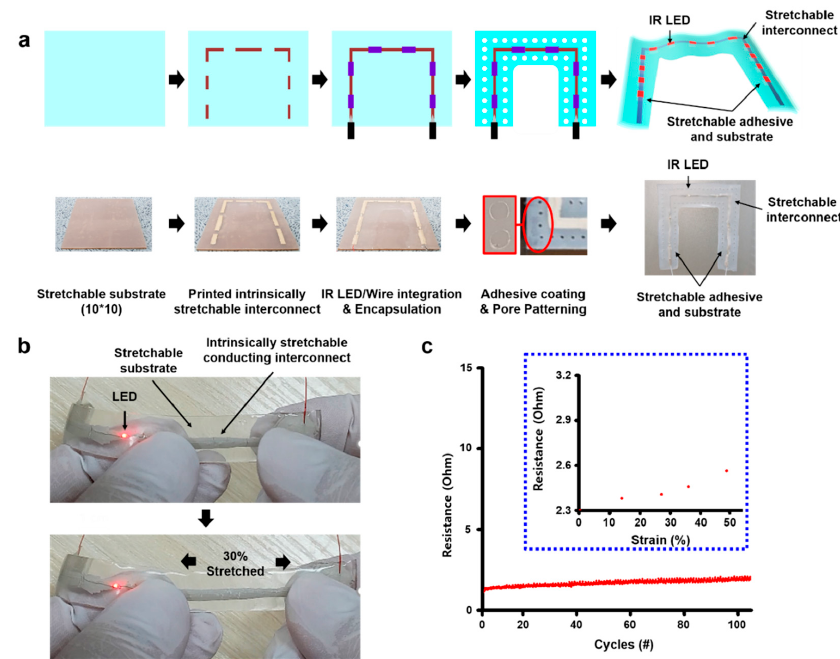
Figure 2. Marker patch fabrication process and the stretchability of interconnect material on the patch. ( a ) Patch fabrication process. ( b ) The stretchability of the patch interconnect part with micro-IR LEDs when it was stretched to 30% by two hands. ( c ) Electrical stability of the interconnect part by 100 cycle stretching test. Inset: the resistance change of the interconnect part by strain.